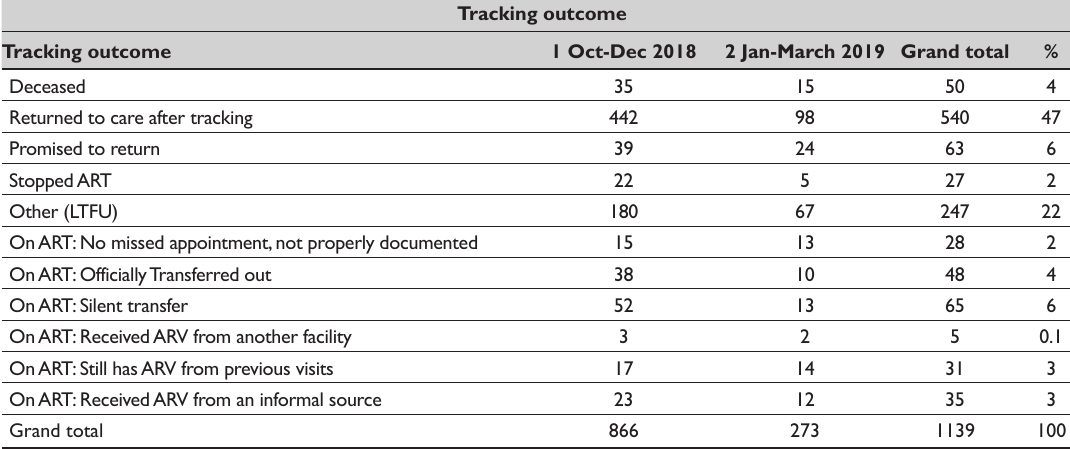
Tracking outcome